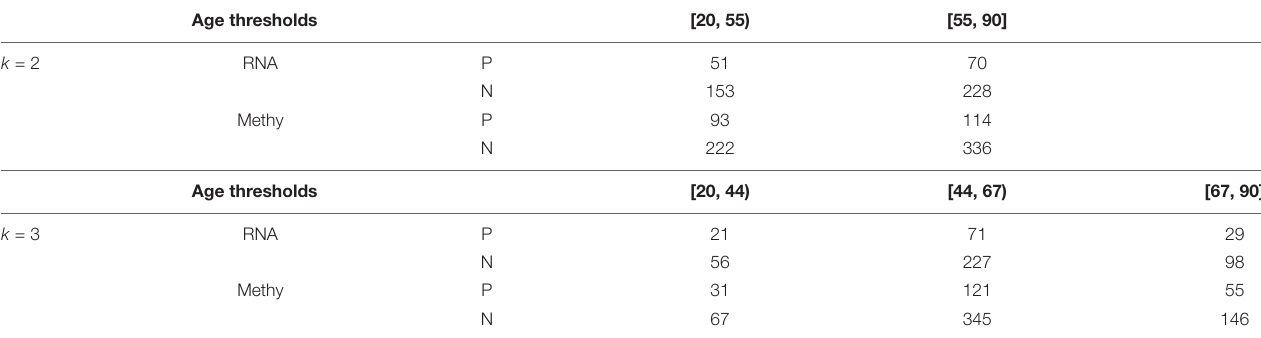
TABLE 1 | Samples with transcriptomes (RNA) and methylomes (Methy) were grouped using the same age bins.